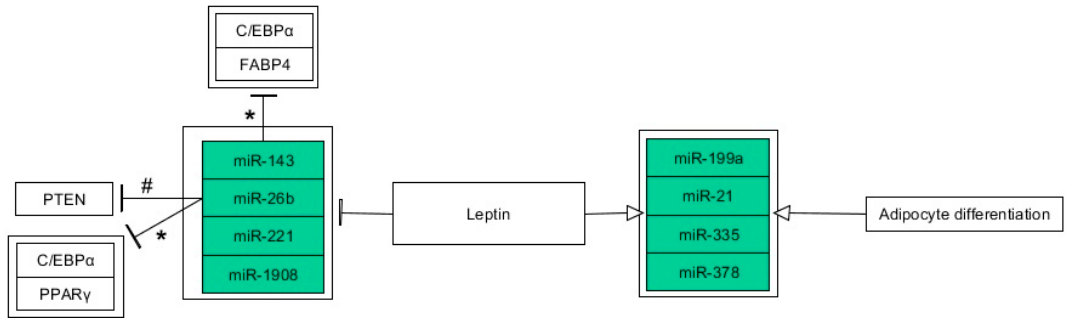
Figure 2. Leptin-mediated miRNA expression changes in adipocytes and during adipogenesis. miRNAs are highlighted in green. Associations are indicated by arrows (stimulation) and T-bars (inhibition). Actions related to boxes refer to all items inside the box. Associations were based on the results of the studies involving leptin administration excluding those marked by asterisks (miRNA